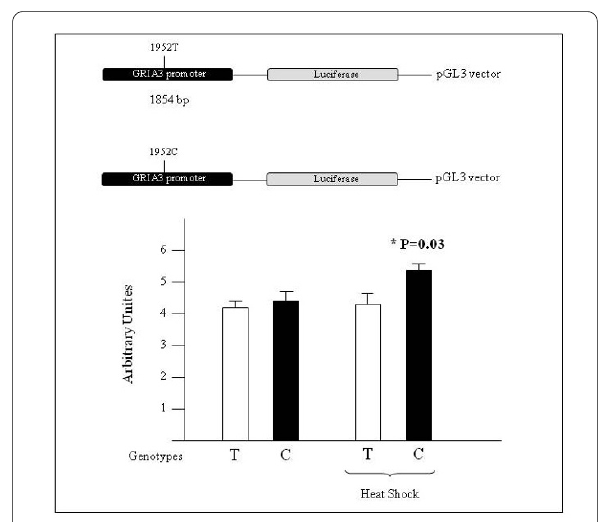
Figure 3 Luciferase assay for GRIA3 promoter activity . Under heat shock condition the luciferase activity generated by the C construct was 1.3-fold greater than that generated by the T construct (p < 0.05 using t-test